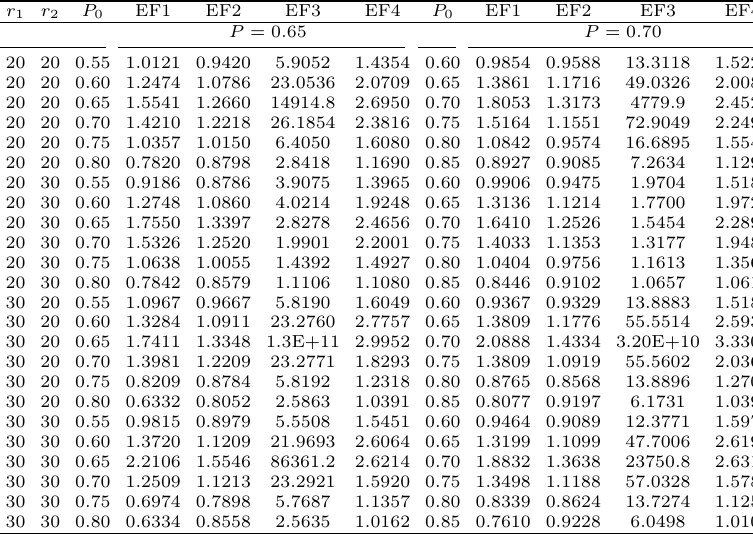
Relative efficiencies of the estimators for ’ P ’ under Type II